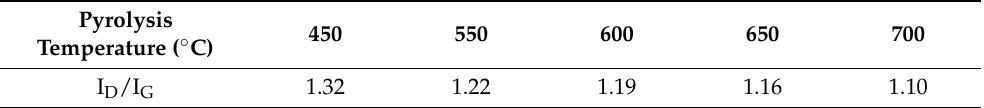
Figure 5. Raman spectra of CMS pyrolyzed at various temperatures. Table 1. Intensity ratio of disordered and graphitic peaks obtained by Raman analysis of CMS pyrolyzed at various temperatures .